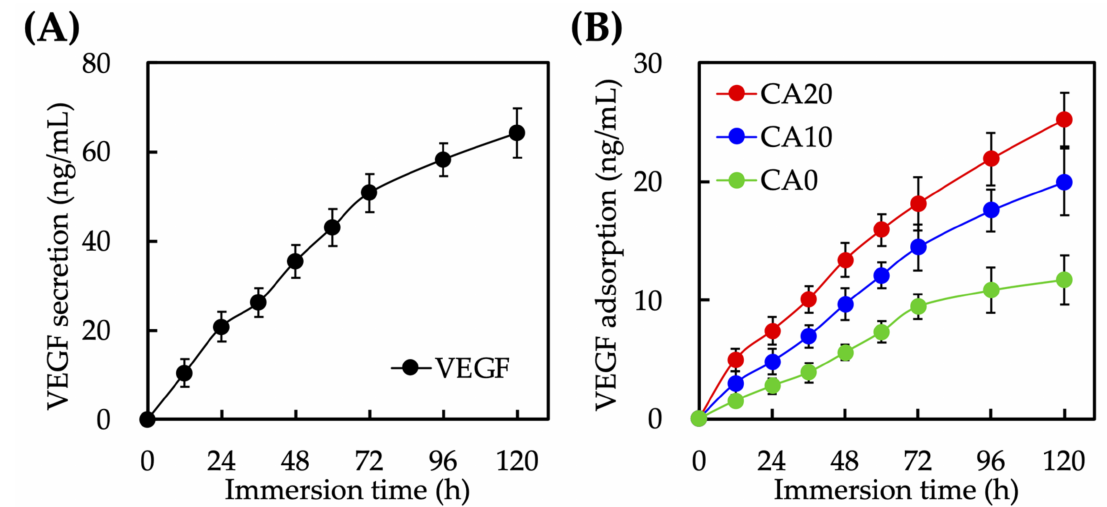
Figure 6. ( A ) VEGF secretion from hDPSCs and ( B ) adsorption on the CA0, CA10, and CA20 scaffold surface for 120 h ( n =